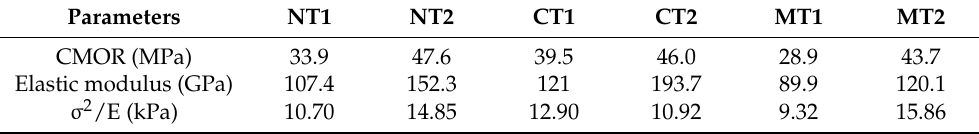
Table 4. Results of strength, elastic modulus, and σ 2 /E of samples calcined at 1450 ◦ C for 5 h.